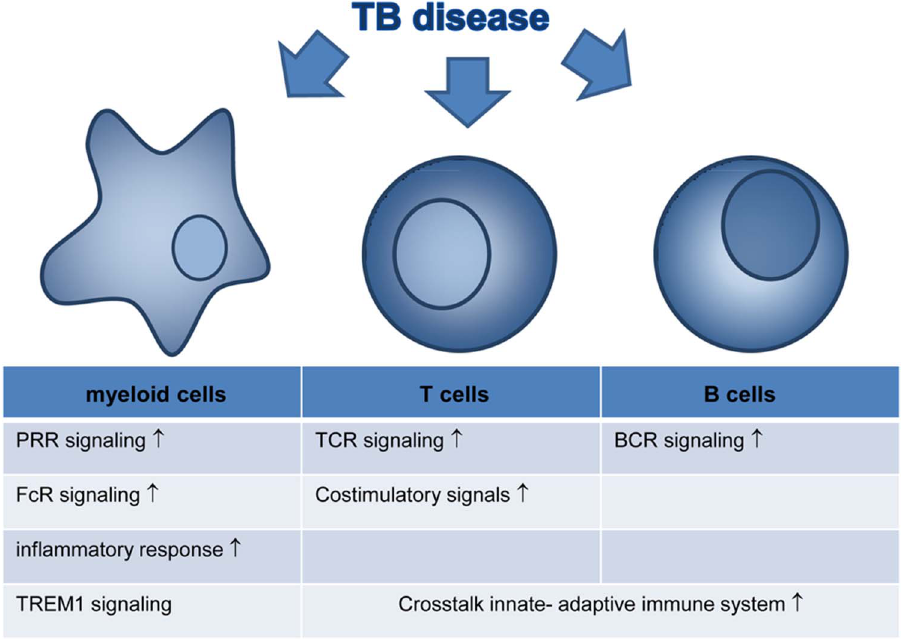
Figure 4. Schematic representation of events during active TB Disease. Pathway and process based analysis suggests that these processes are key players in TB disease pathogenesis.